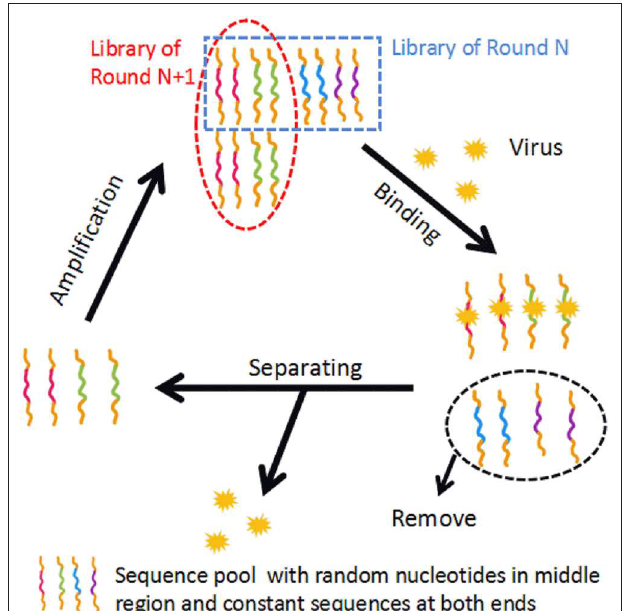
FIGURE 1 | The basic mechanism of conventional SELEX. In the binding step, the sequence pool is incubated with the target. In the separating step, unbound sequences are removed and bound sequences are separated from the target. In the amplification step, the separated sequences are amplified, building a new sequence pool for the next iteration of